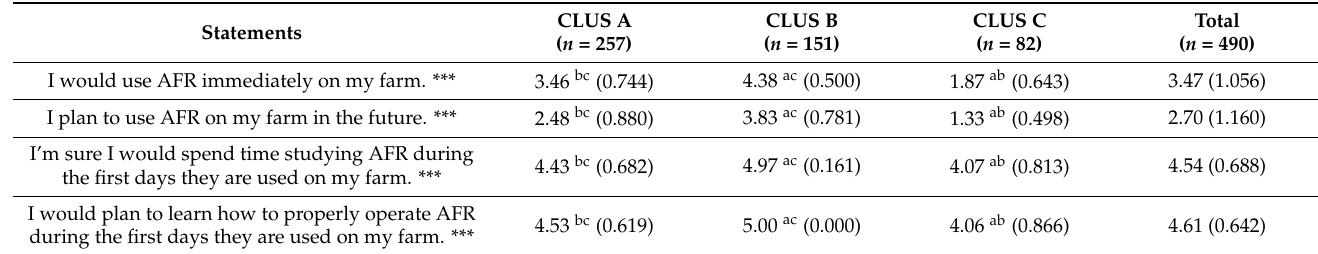
Table 1. Results of the clustering